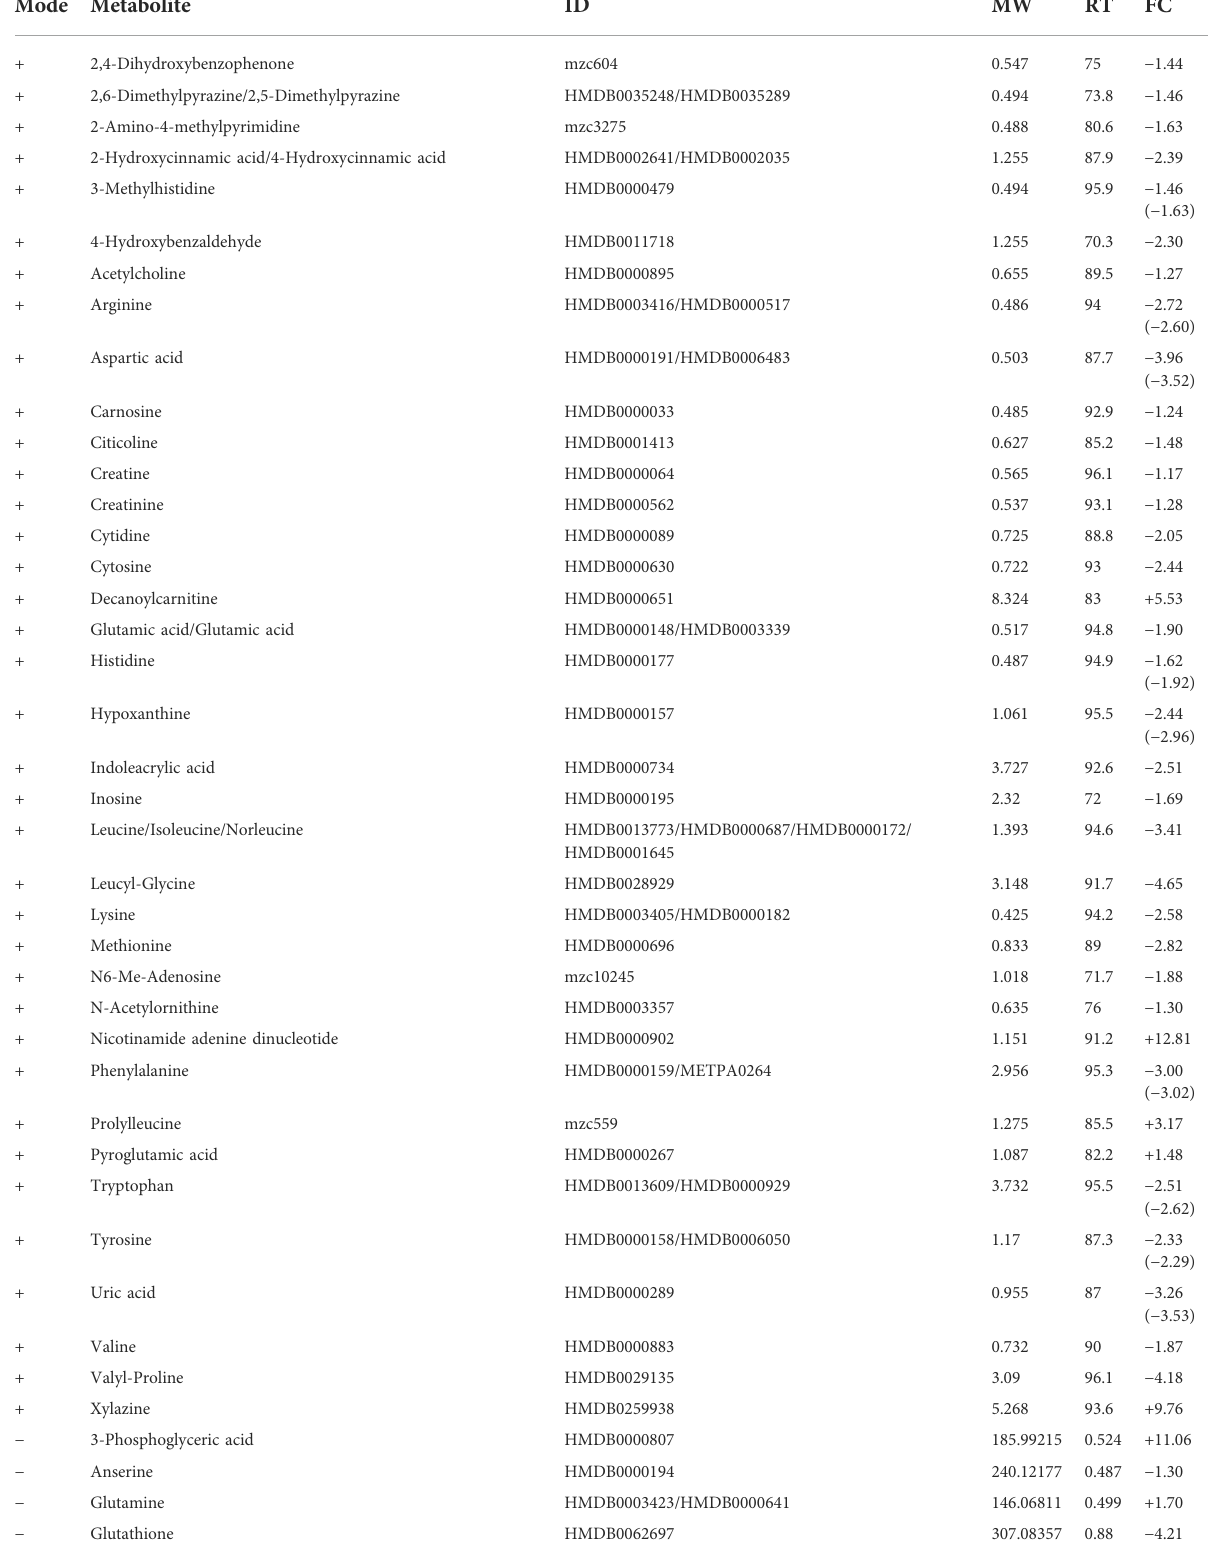
TABLE 3 List of metabolites in AC vs.